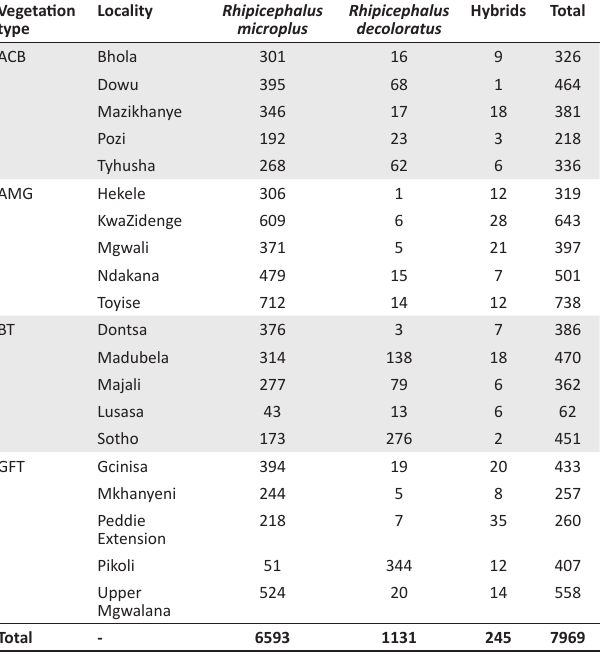
TABLE 2: Total number of Rhipicephalus microplus , Rhipicephalus decoloratus and Rhipicephalus decoloratus – Rhipicephalus microplus suspected hybrid larvae collected from vegetation at 20 communal areas in the Eastern Cape province of South Africa. Vegetation type